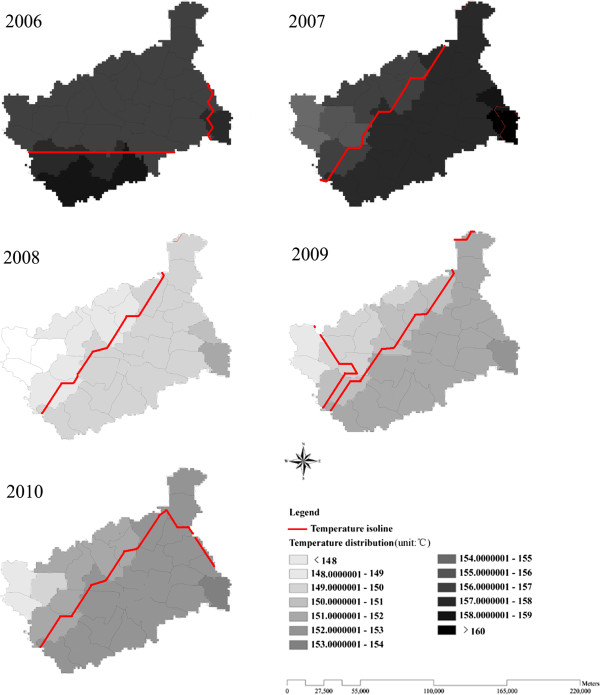
Yearly average temperature at county level from 2006 to 2010 in Yongcheng prefecture, China. The county-lever areas are colour-coded according to yearly average temperature, with higher temperature distributed in the Southeast of Yongcheng prefecture.